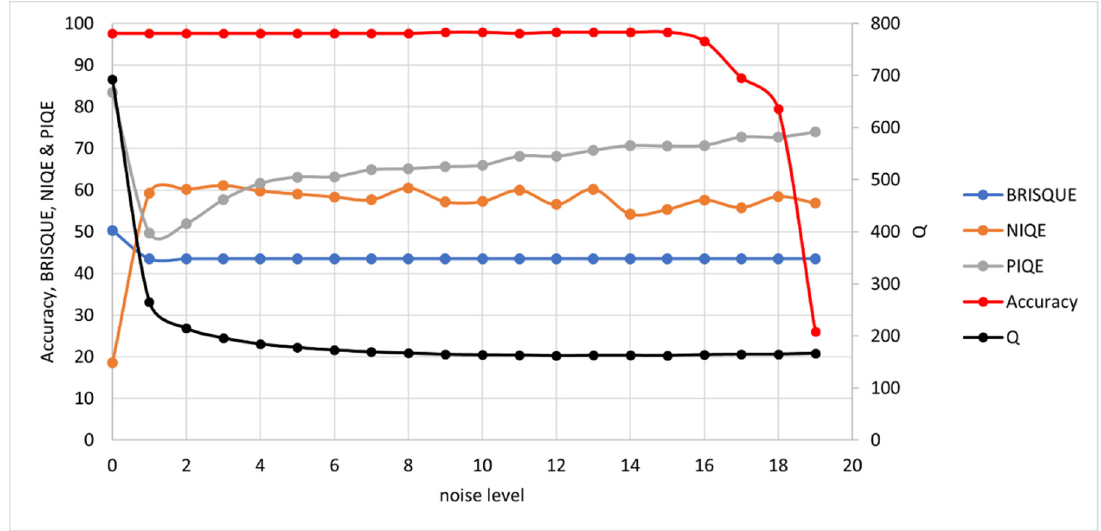
Figure 5. OCR Accuracy and Quality Metrics vs. Noise Level. Note: high BRISQUE, NIQE and PIQE values denote low quality while high Q values denote high quality. A separate axis is used for Q here as the unnormalized Q value tends to be considerably higher than the other NR-IQAs, which tend to stay in the range 0 to 100.